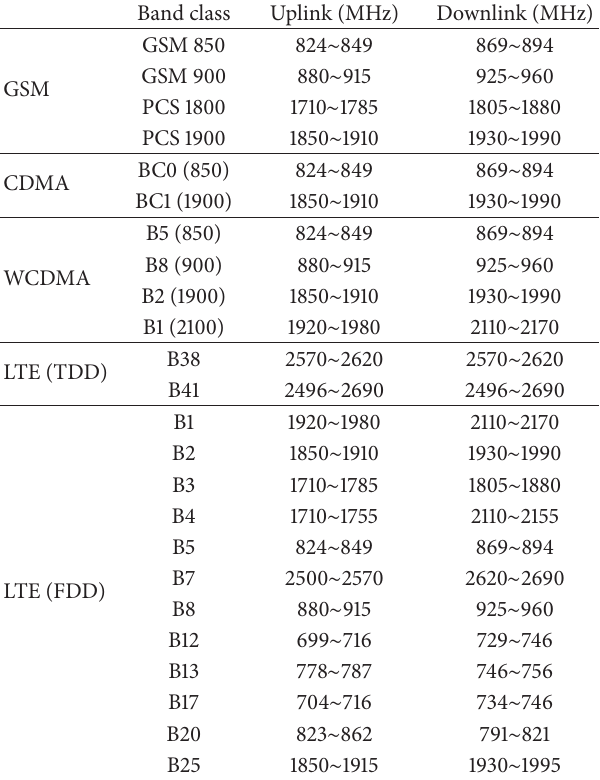
Table 1: Frequency spectrum allocation in mobile wireless commu- nication